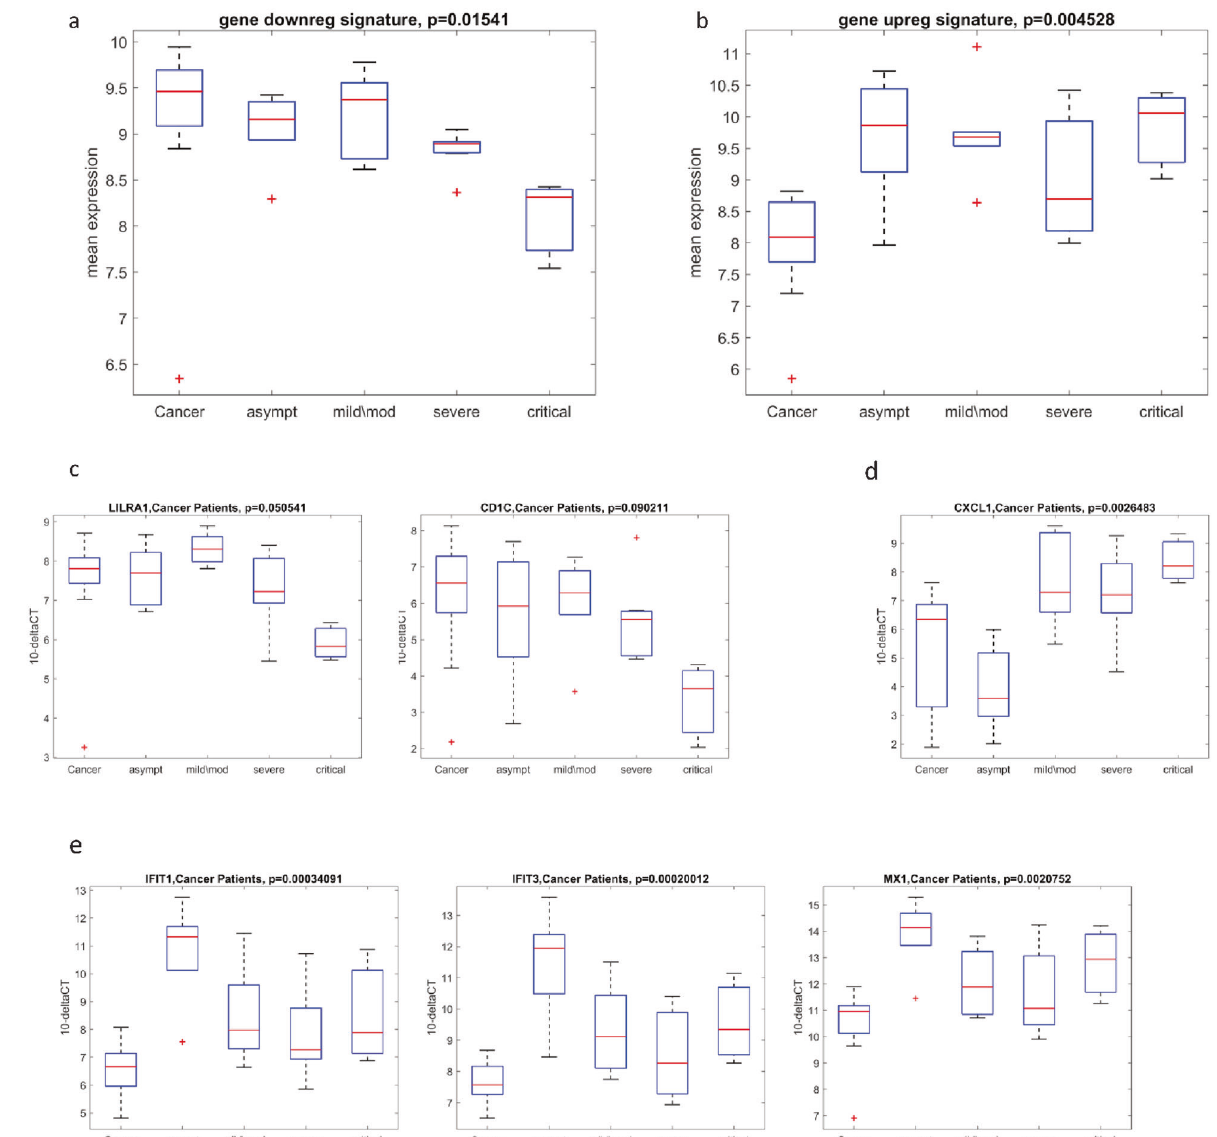
Fig. 7 Evaluation of the gene signature on COVID-19 cancer patients in COVID-19 disease severity-manner. a Box plot of the COVID-19 disease severity-dependent distributions of downregulated gene signature in cancer ( n = 12) and COV/cancer ( n = 21) (asympt ( n = 4), mild/ mod ( n = 7), severe ( n = 7), critical ( n = 3)) validation cohorts. b Box plot of the COVID-19 disease severity-dependent distributions of upregulated gene signature inn cancer ( n = 12) and COV/cancer ( n = 21) validation cohorts. c Box plot of the COVID-19 disease severity- dependent distributions of LILRA1 and CD1C in cancer ( n = 12) and COV/cancer ( n = 21) validation cohorts. d Box plot of the COVID-19 disease severity-dependent distributions of CXCL1 in cancer ( n = 12) and COV/cancer ( n = 21) validation cohorts. e Box plot of the COVID-19 disease severity-dependent distributions of IFIT1, IFIT3, and MX1 in cancer ( n = 12) and COV/cancer ( n = 21) validation